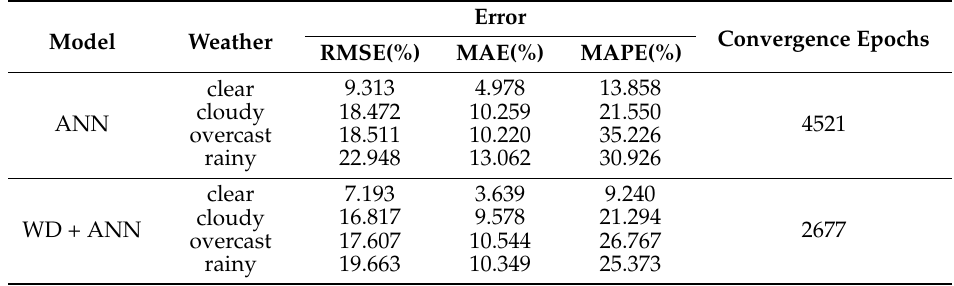
Table 4. Comparison of forecasting performance between ANN and WD + ANN model on clear, cloudy, overcast, rainy